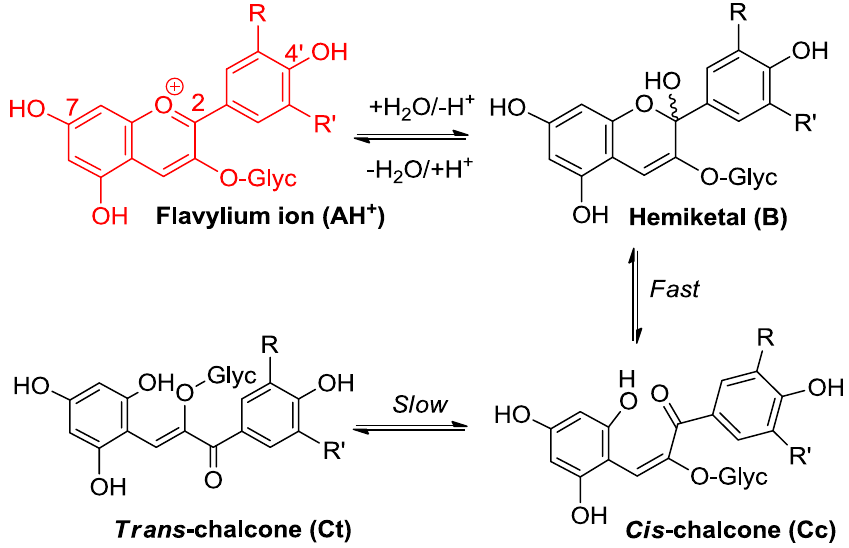
Figure 3. Flavylium ions are hard electrophiles reacting at C2 with O-centered nucleophiles, such as water (water addition followed by formation of minor concentrations of chalcones).